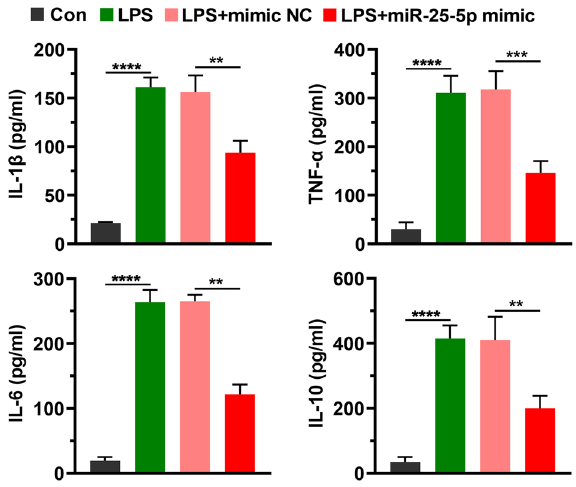
Figure 3. miR-25-5p alleviates inflammatory responses in LPS-stimulated CTX TNA2 cells. Effects of miR- 25-5p mimic on IL-1β, TNF-α, IL-6, and IL-10 protein concentration determined by ELISA of LPS-stimulated CTX TNA2 cells. The independent t -test was applied to the comparison between groups. Values are shown as the mean ± SD. Con: negative control of LPS, LPS: lipopolysaccharide, mimic NC: negative control of miR-25-5p